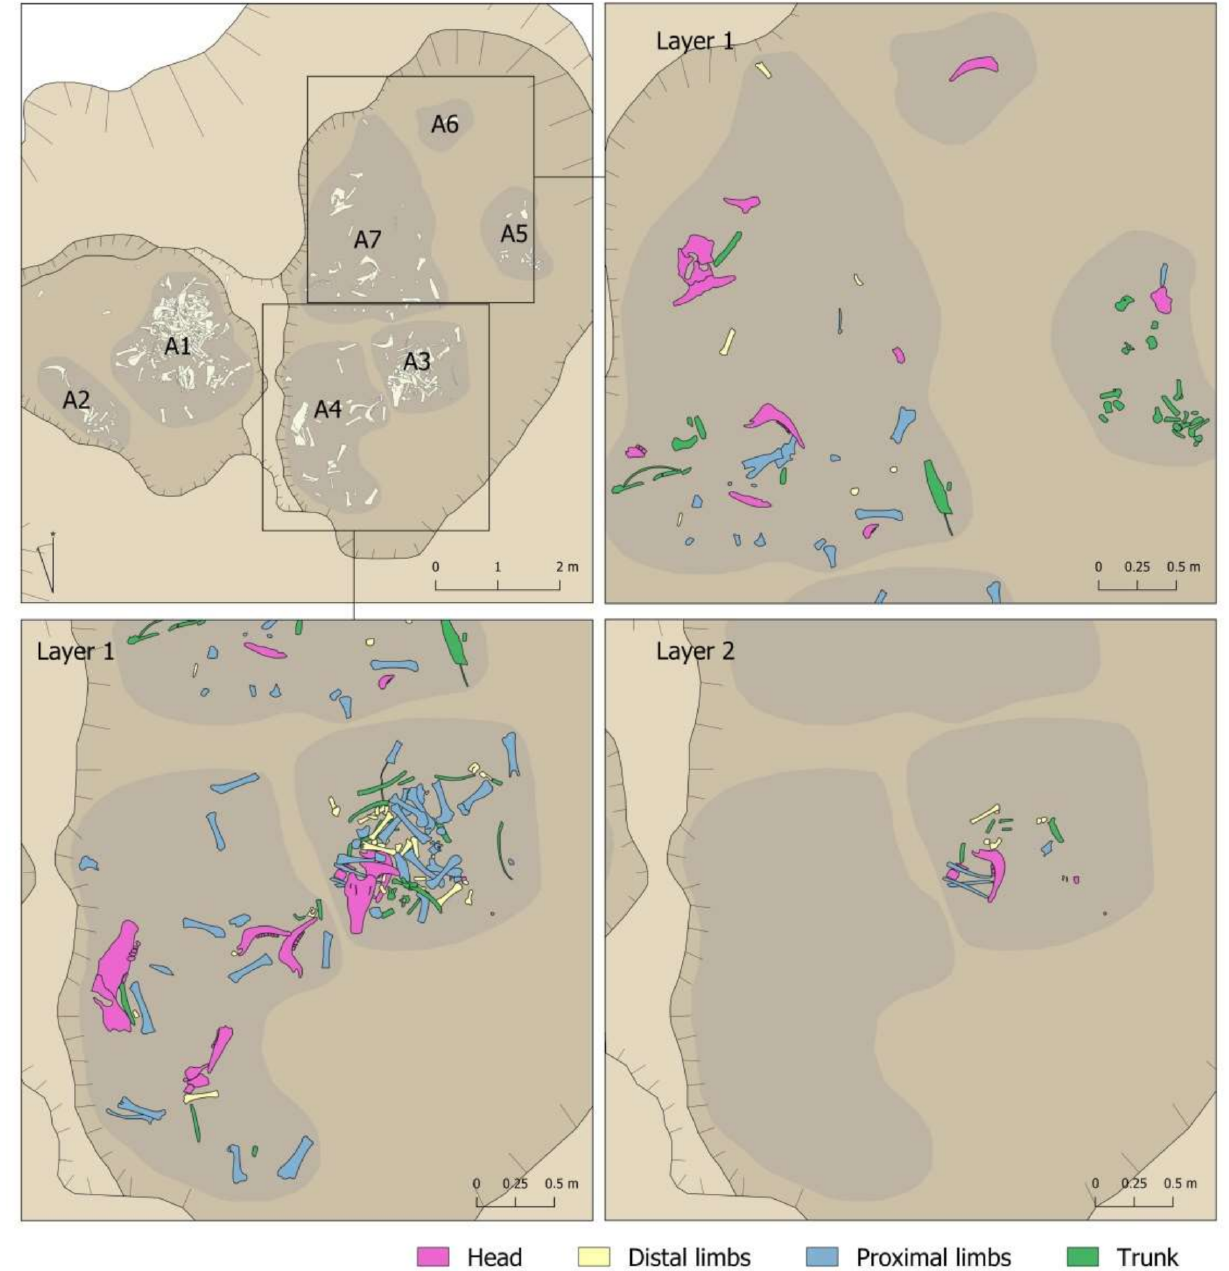
Figure 9. Body-part representation documented in the different layers of Areas 3, 4, 5, 6, and 7 of the Vilauba